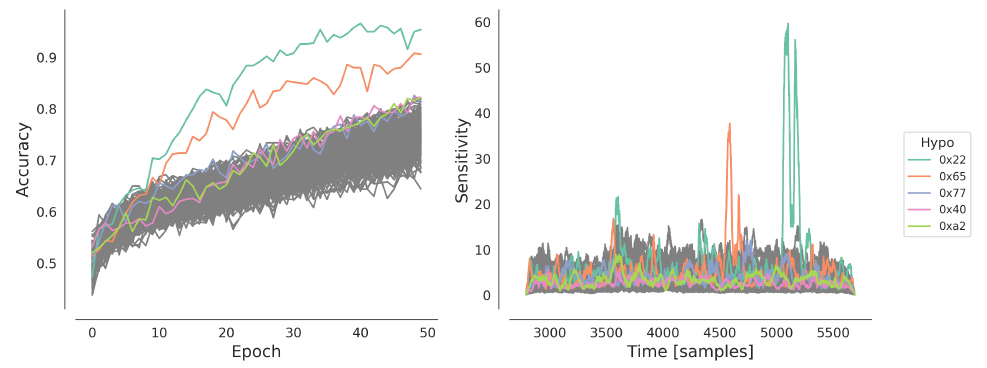
Figure 26: Performing the second step of the attack (byte 0 and 1) with DDLA, using 256 traces. Accuracies (left) and sensitivity analysis